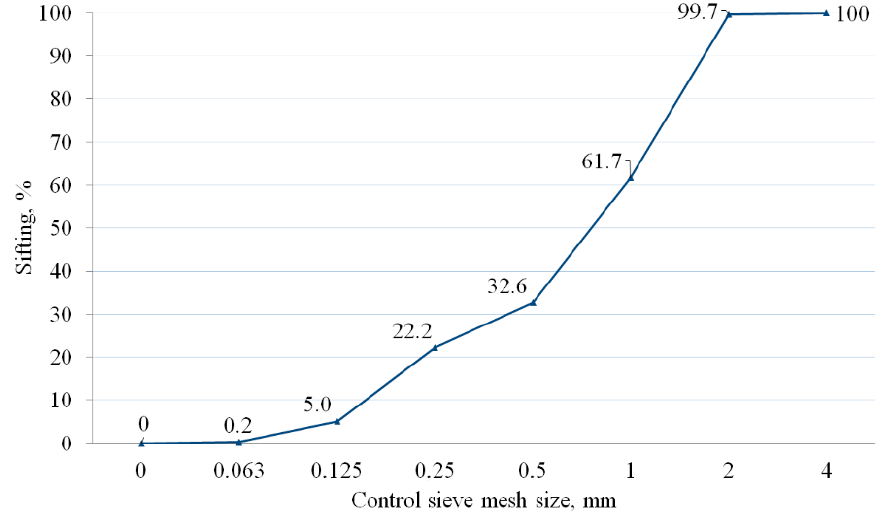
Figure 4. Sand grain size distribution curve.